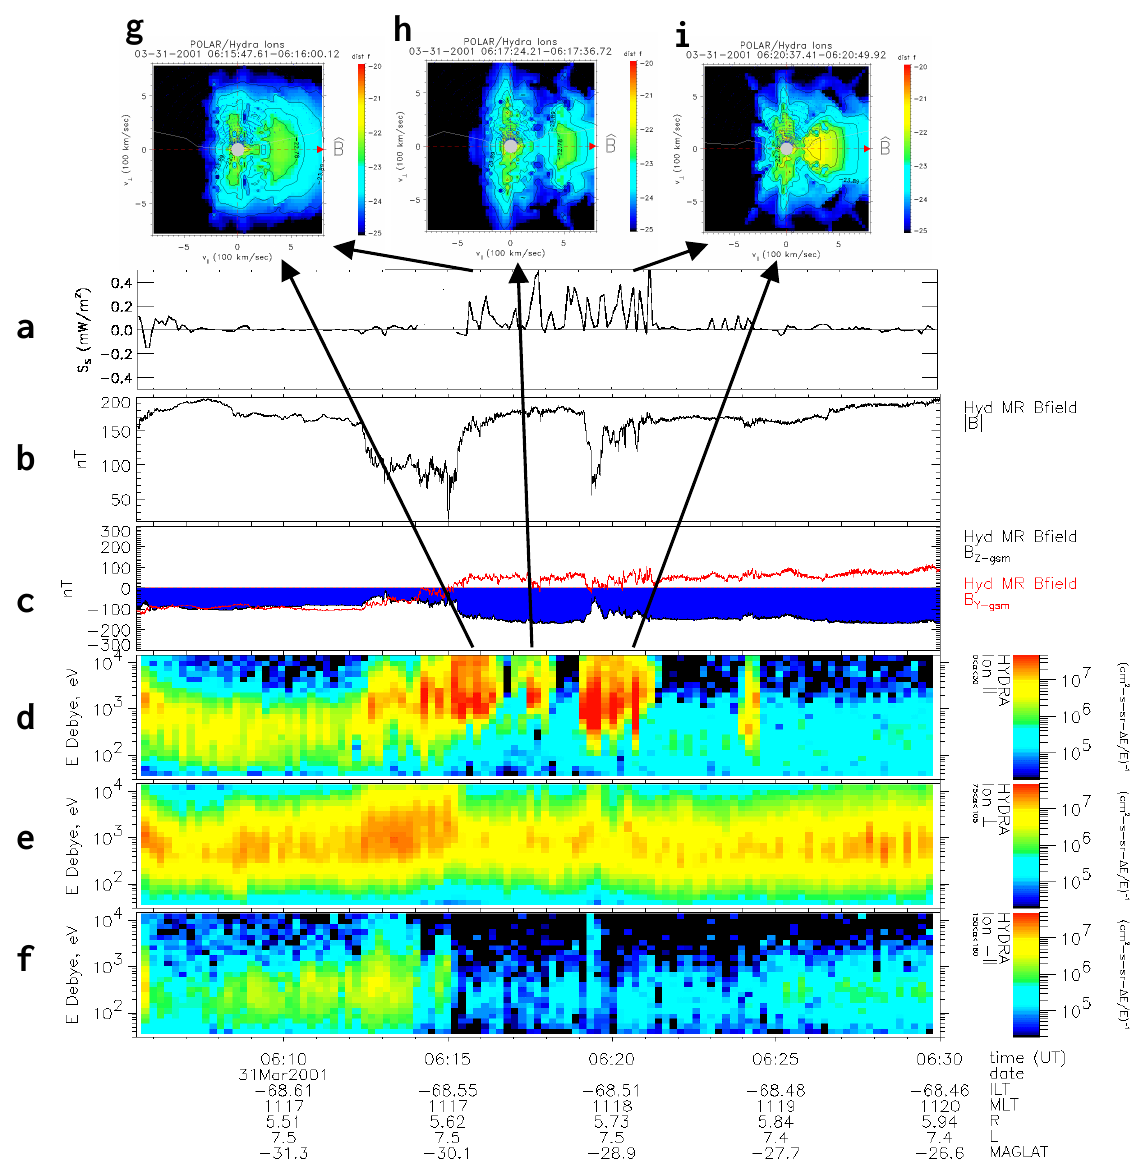
Fig. 18. Correlation of the wave Poynting flux measured by Polar above the cusp on 31 March 2001, with accelerated particles associated with the outer separatrix separating open magnetic field lines from IMF magnetic field lines in the magnetosheath.